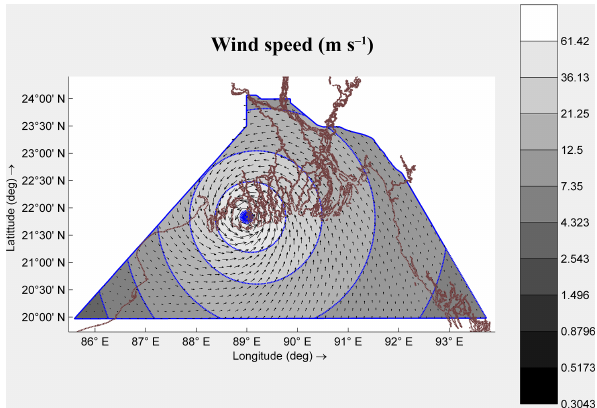
Figure 2. Distribution of the wind field over the model domain for TC Sidr during landfall generated using Holland’s equation.